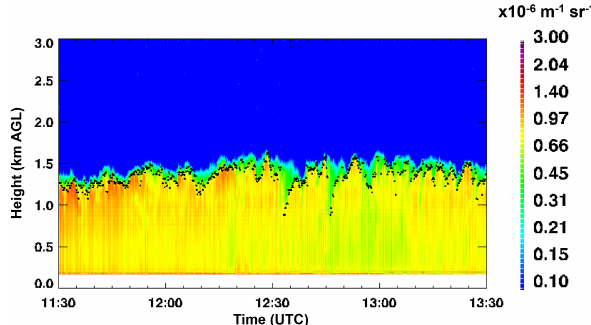
Figure 4. Time–height cross section of the particle backscatter co- efficient, β par , between 11:30 and 13:30UTC on 20 April 2013. The black line in the figure identifies the CBL height z i